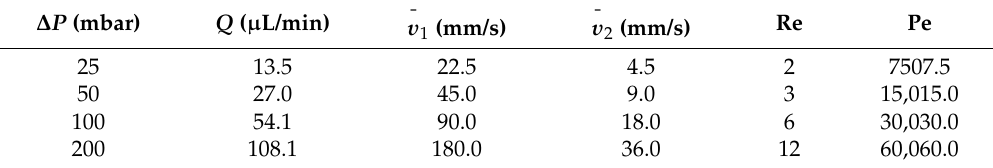
Table 1. Calculated flow rates, velocities, Reynolds number (Re), and Peclet number (Pe) for different pumping pressures. υ 1 and υ 2 correspond to the flow velocity of glass chips with heights of 100 µ m and 500 µ m, respectively.